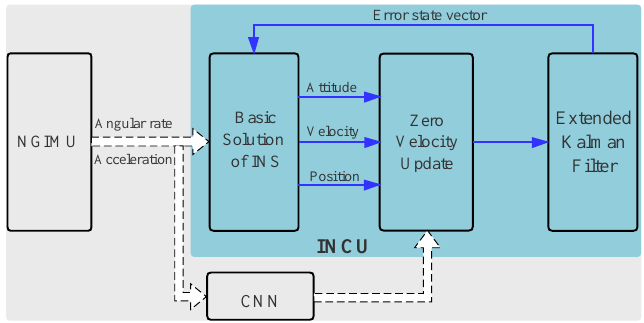
Figure 7. Block diagram of the INCU